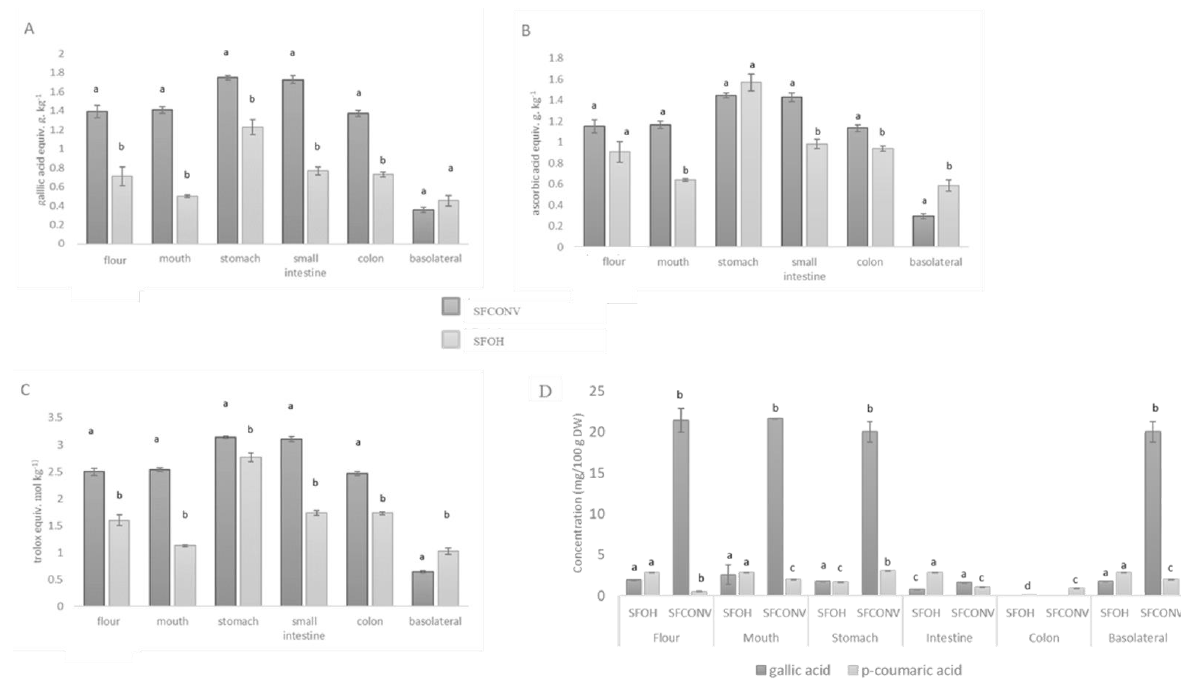
Figure 2. Total phenolics content ( A ), antioxidant capacity by ABTS ( B ), and ORAC ( C ) methods, gallic acid and p - coumaric acid concentration (D) throughout gastrointestinal tract of samples. SFCONV refers to solid fraction obtained after conventional extraction; SFOH refers to solid fraction obtained after ohmic heating extraction. Significant differences (p < 0.05) among extracts for each digested fraction are indicated by Greek letters.